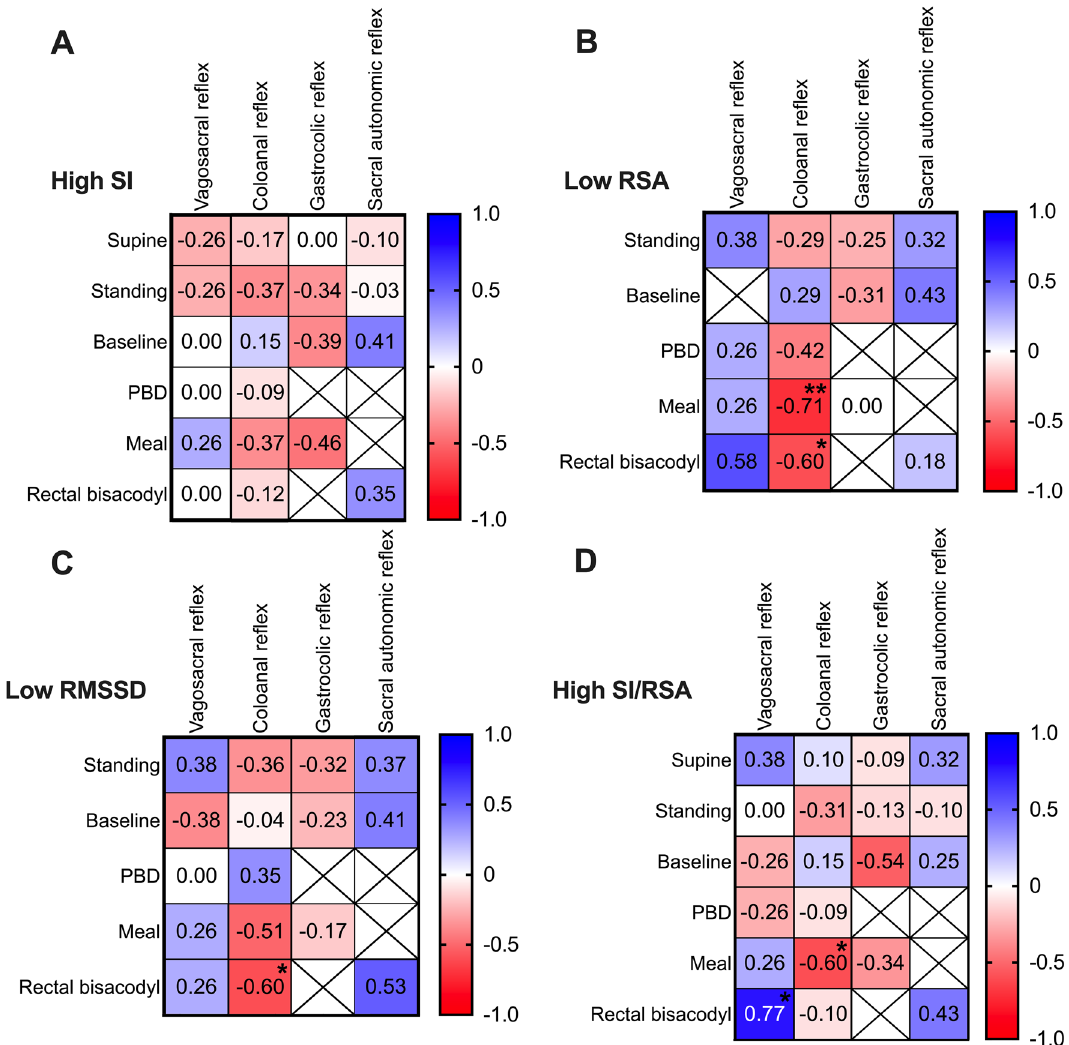
Figure 4. Correlation between autonomic nervous system parameters and the presence of colonic reflexes in patients with chronic constipation using a Pearson correlation matrix. We assessed ( A ) high sympathetic (SI) tone (supine and baseline) and sympathetic (SI) reactivity to stimuli, ( B ) and ( C ) low parasympathetic (RSA, RMSSD) tone (supine and baseline) and parasympathetic reactivity to stimuli, and ( D ) overall sympathetic dominance as reflected in a high ratio of SI/RSA. Low parasympathetic tone during supine did not occur in any patient, thus was excluded. Correlations that are not theoretically associated (e.g. PBD does not stimulate the gastrocolic reflex) were excluded. Presence of low RSA and low RMSSD reactivity to meal and rectal bisacodyl showed a significant negative correlation with the presence of the coloanal reflex (CAR): all patients without the coloanal reflex had low RSA reactivity. * P < 0.05, **P <